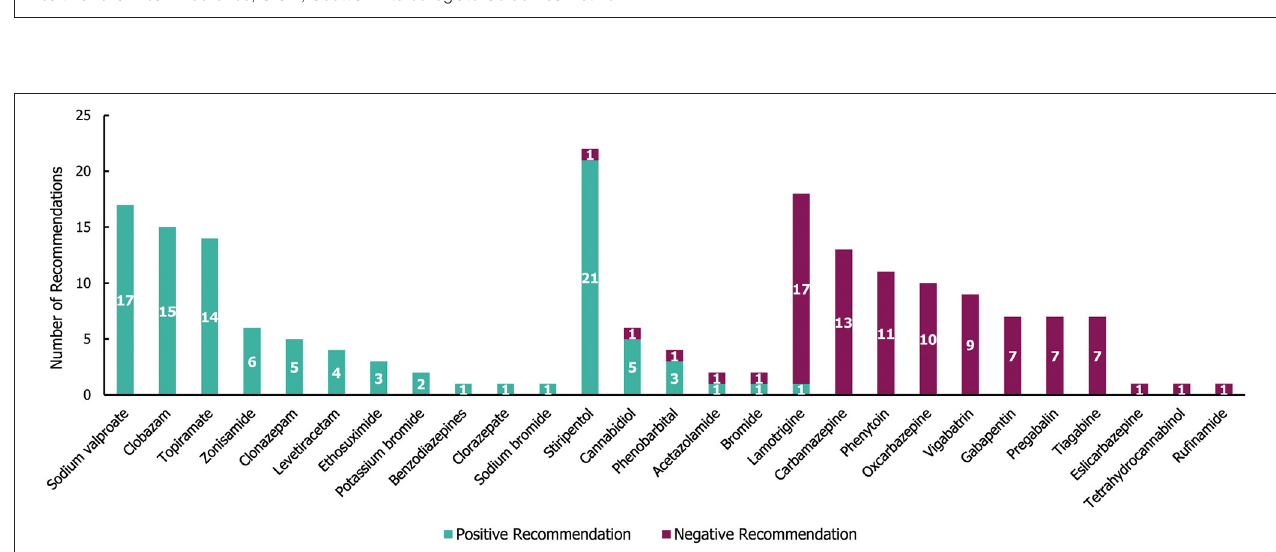
FIGURE 7 | Treatment recommendations for Dravet syndrome. N = 190 (101 positive and 89 negative recommendations) from 29 guidelines. Positive recommendation: use of an individual ASM that was recommended for use in a specific indication, irrespective of the line of treatment (e.g., first line) or whether the treatment was adjunctive; Negative recommendation: an individual ASM treatment that was highlighted as a potential option by a guideline but whose use was recommended against (for any reason) in a specific indication, irrespective of the line of treatment or whether the treatment was adjunctive.